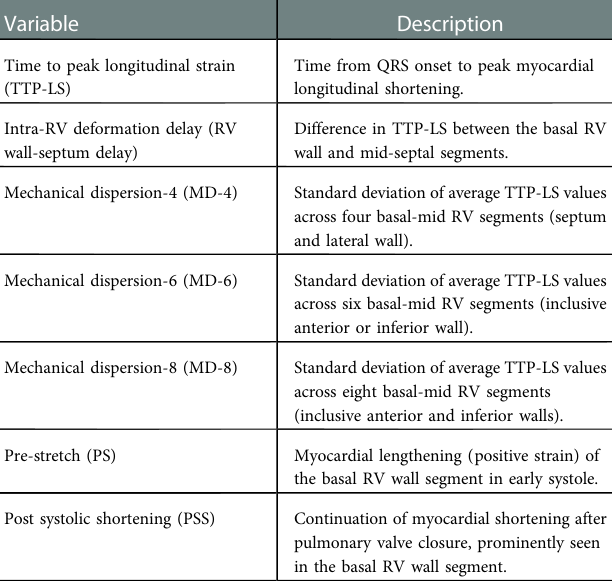
TABLE 1 De fi nitions of RV dyssynchrony